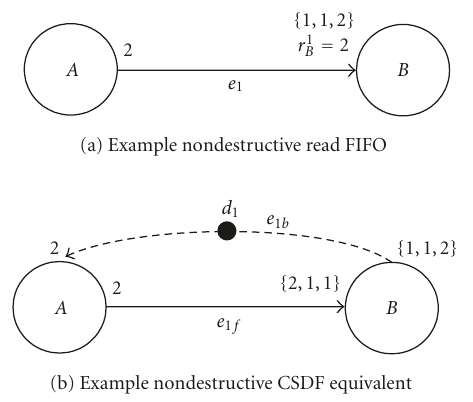
Figure 10: Example nondestructive read keeping one container for data reuse.